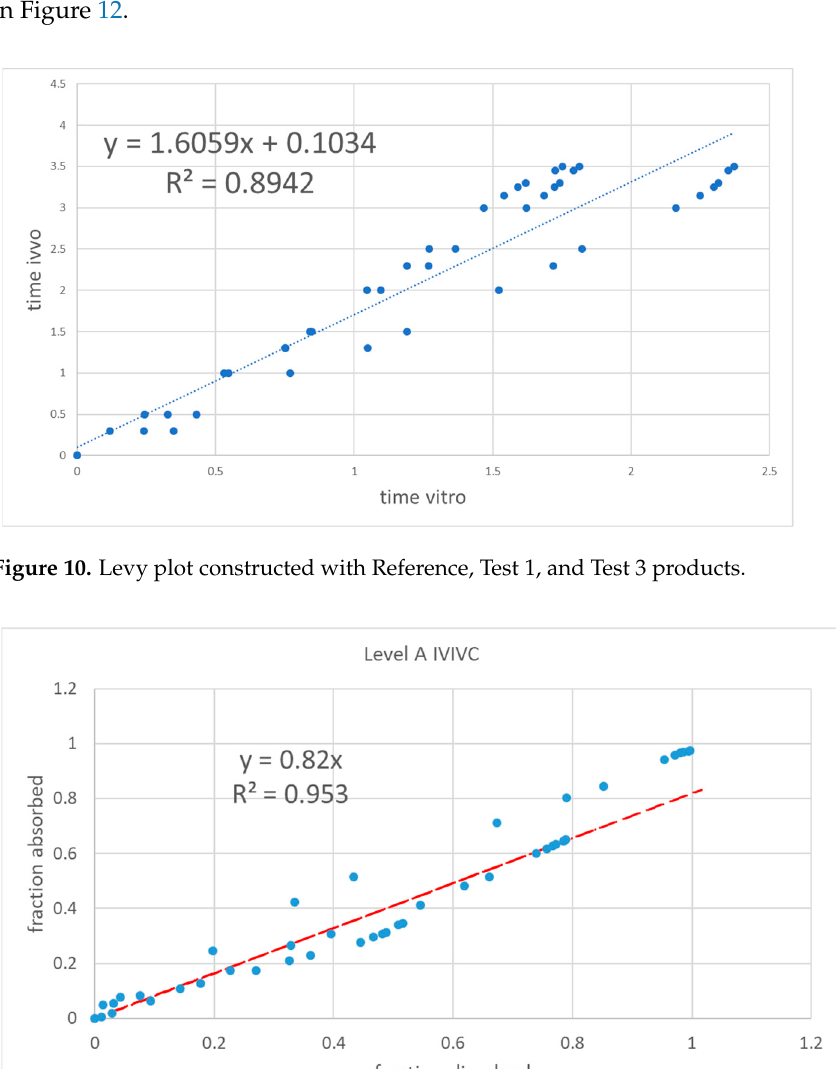
Figure 11. Two ‐ step level ‐ A IVIVC developed with Reference, Test 1, and Test 3 products. Figure 11. Two-step level-A IVIVC developed with Reference, Test 1, and Test 3